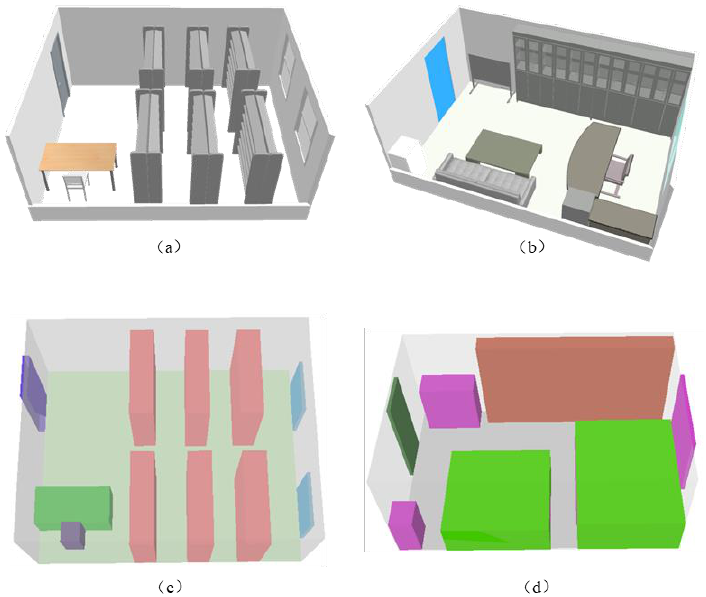
Figure 16. Functional subspace model:( a ) a three-dimensional model of the warehouse. ( b ) a three-dimensional model of the office. ( c , d ) the modeling results of the indoor functional subspaces.